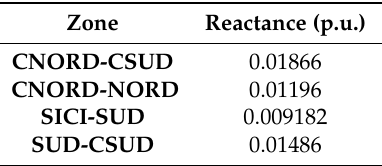
Table 4. Reactance (p.u.) of the inter-zonal connections.